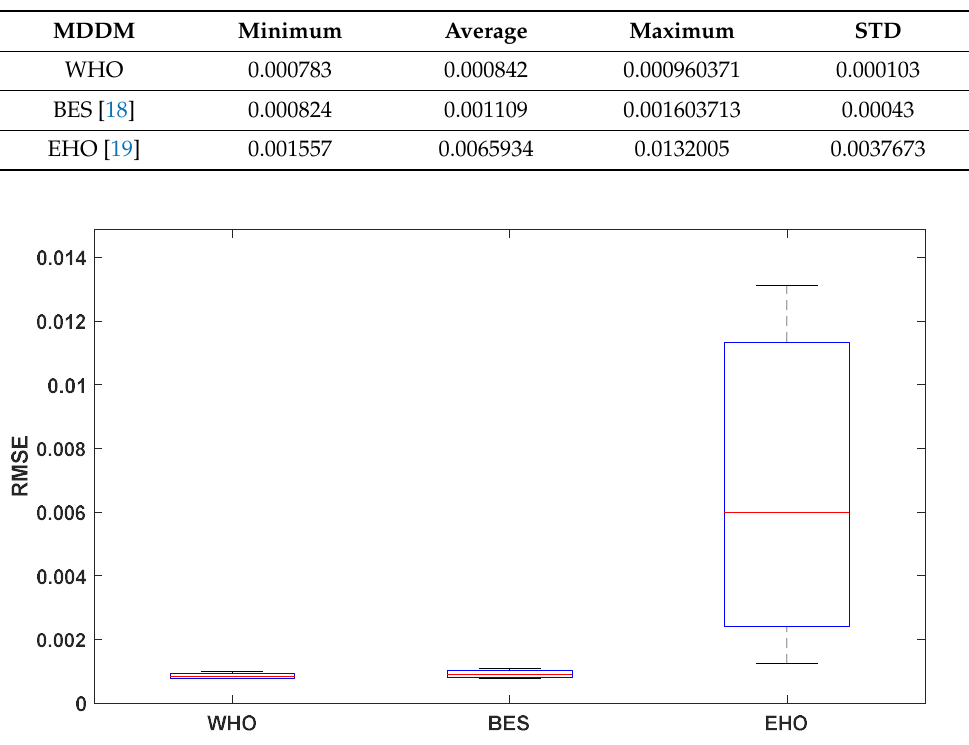
Figure 10. Boxplot figure of all algorithms for 30 independent runs applied to MTDM. Table 4. The statistical results of MDDM for WHO and other algorithms.